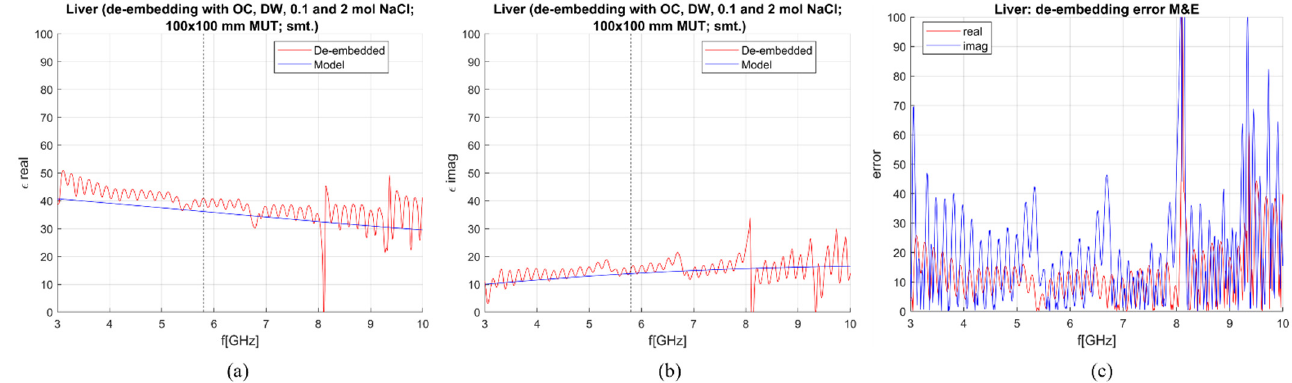
Figure 12. M&E de-embedding with 1st calibration option; DW, OC, 0.1 mol and 2 mol NaCl (smoothing applied): ( a ) Calculated vs. reference ε ’; ( b ) Calculated vs. reference ε ’’; ( c ) Sensitivity (de-embedding error) for ε ’ (“real”) and ε ’’ (“imag”).